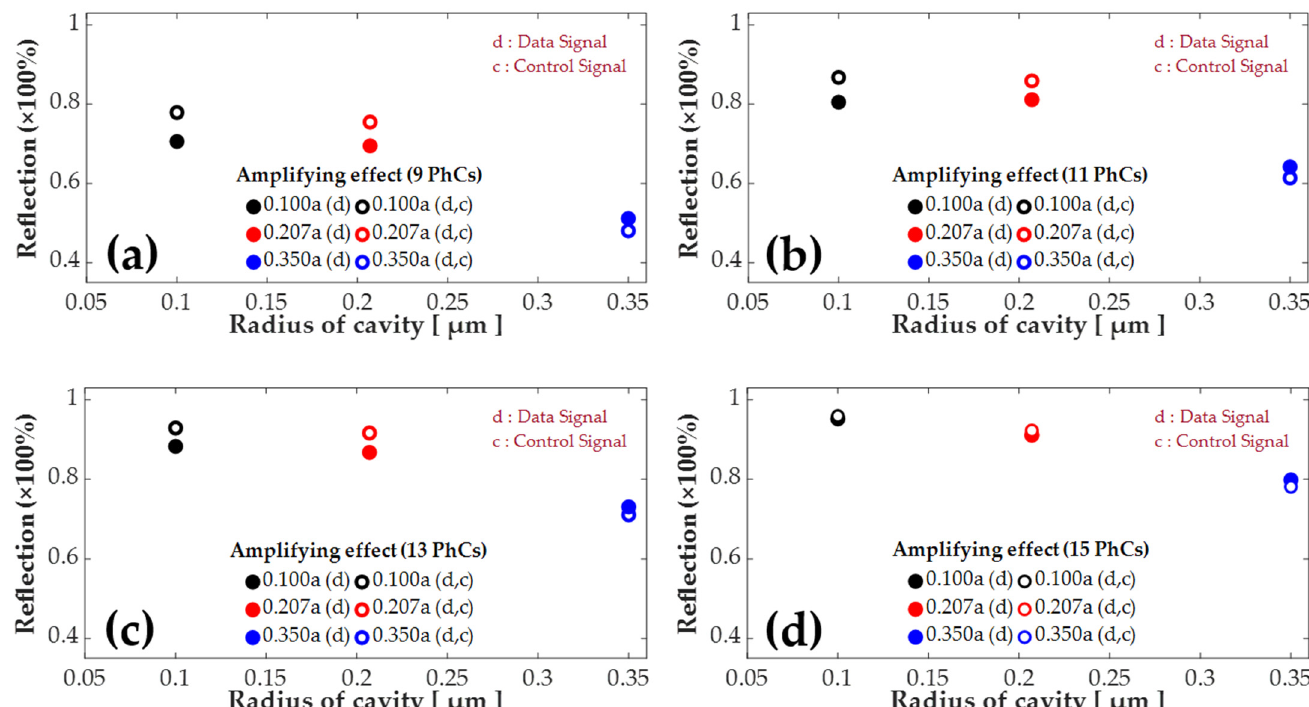
Figure 10. Reflection peaks vs the cavity-radius with single source response plotted in solid circles and dual source (data and control signal) plotted as hollow circles. ( a ) 9 PhC-elements ( b ) 11 PhC-elements ( c ) 13 PhC-elements ( d ) 15 PhC-elements.